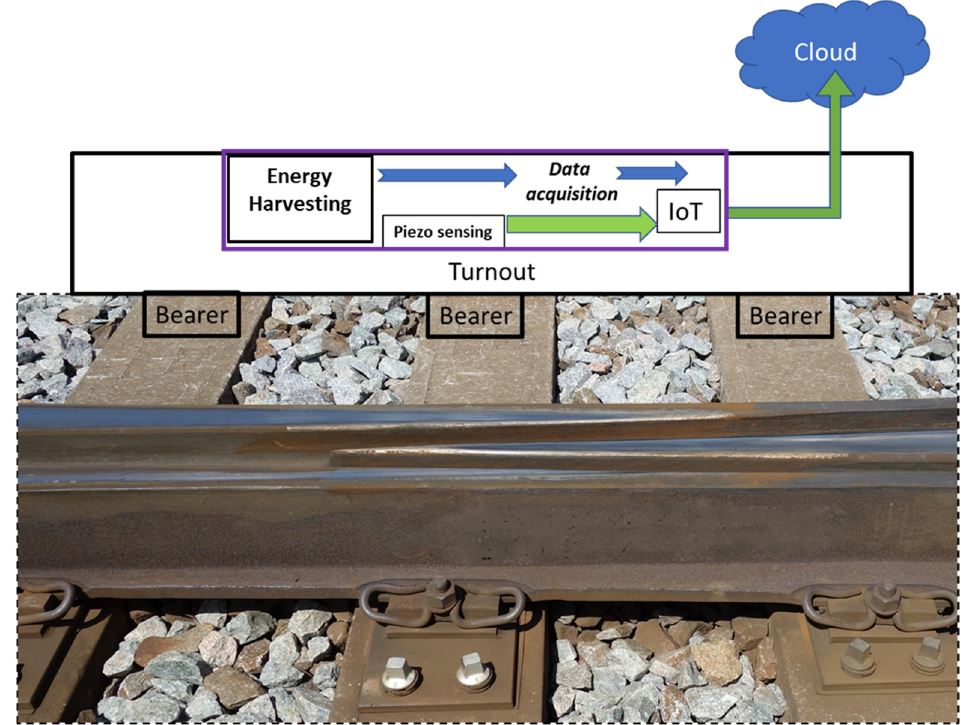
Figure 17. Proposed concept of smart turnout based on energy harvesting.